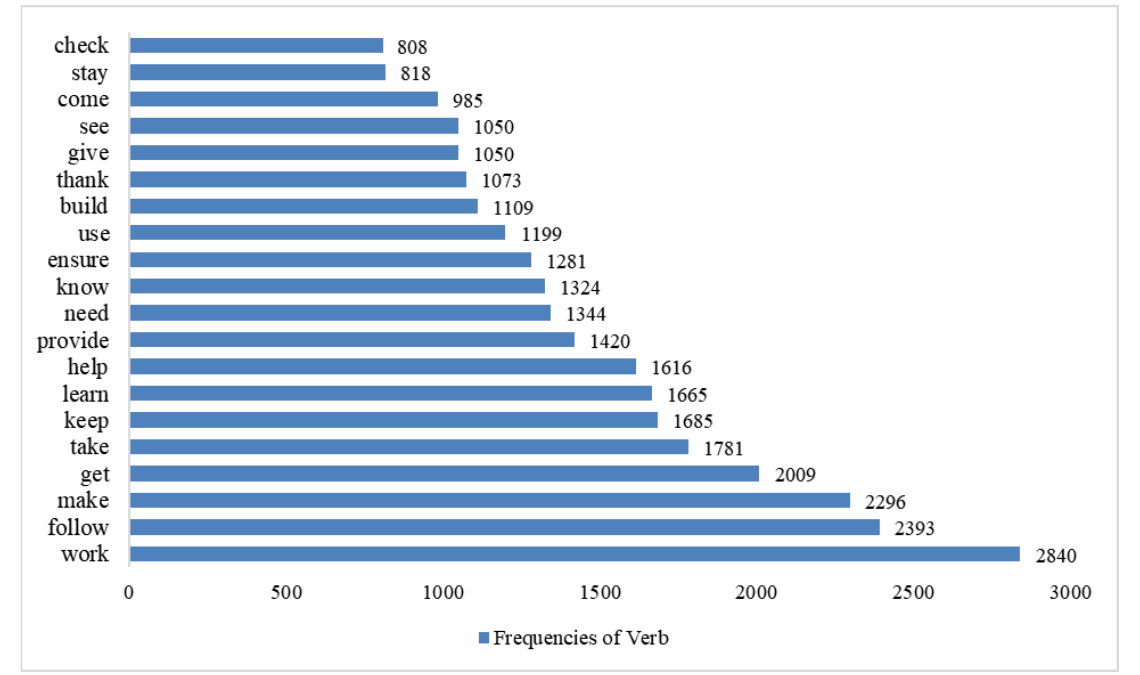
Figure 9. Frequencies of verbs about the sentiment analysis in construction health and safety.